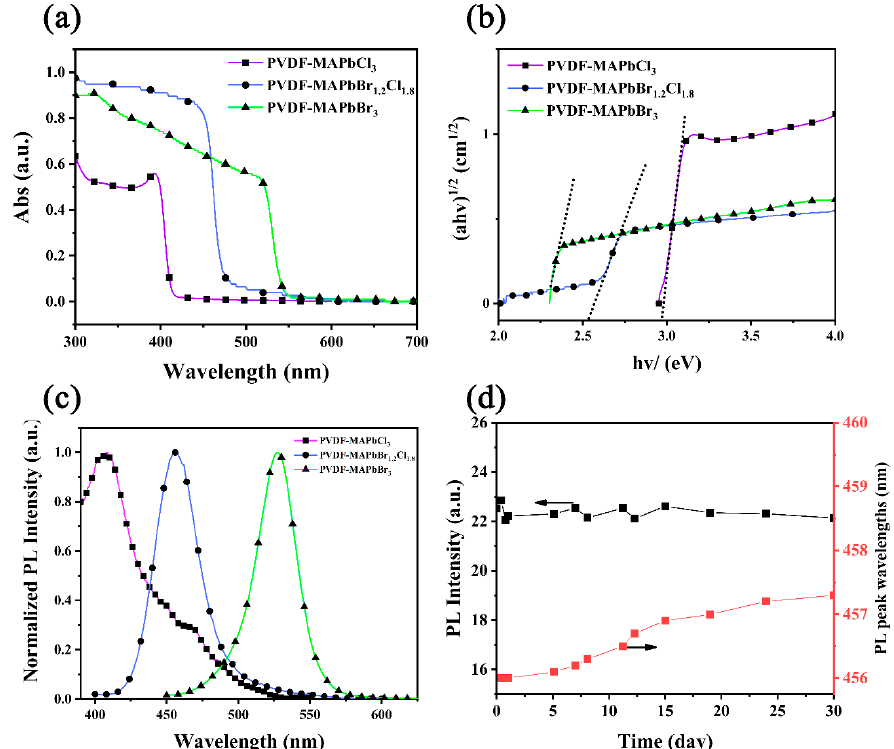
Figure 3. ( a ) Normalized absorption spectra, ( b ) Tauc plot and ( c ) normalized photoluminescence (PL) spectra of PVDF-perovskite quantum dots (PQDs) membranes. ( d ) Daily record data of the PL peak value and its wavelength position of the PVDF-MAPbBr 1.2 Cl 1.8 membrane which was kept in the air at room temperature.